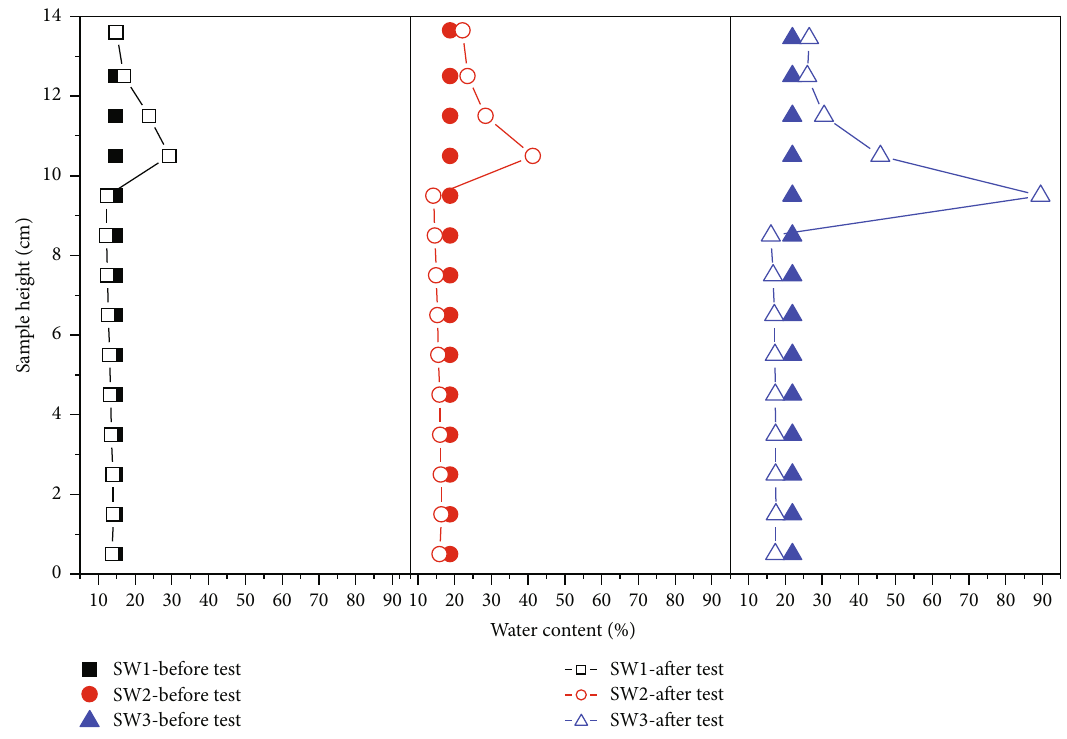
Figure 12: Water content of samples before and after the tests.